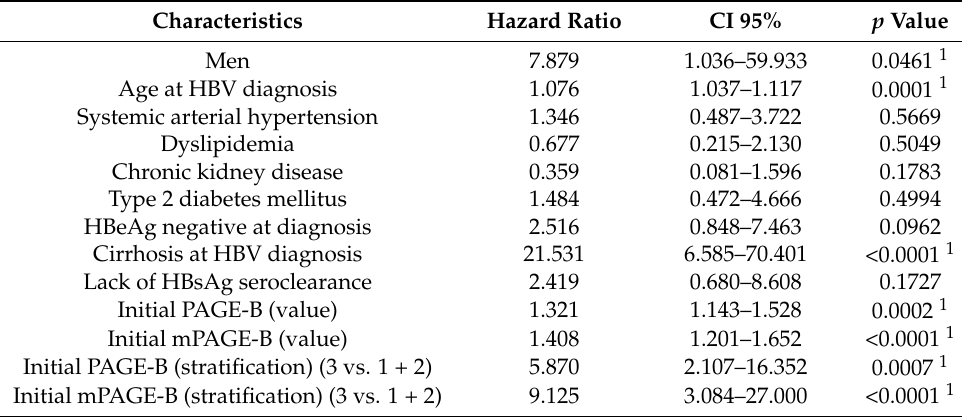
Table 3. Factors associated with HCC occurrence—univariate logistic